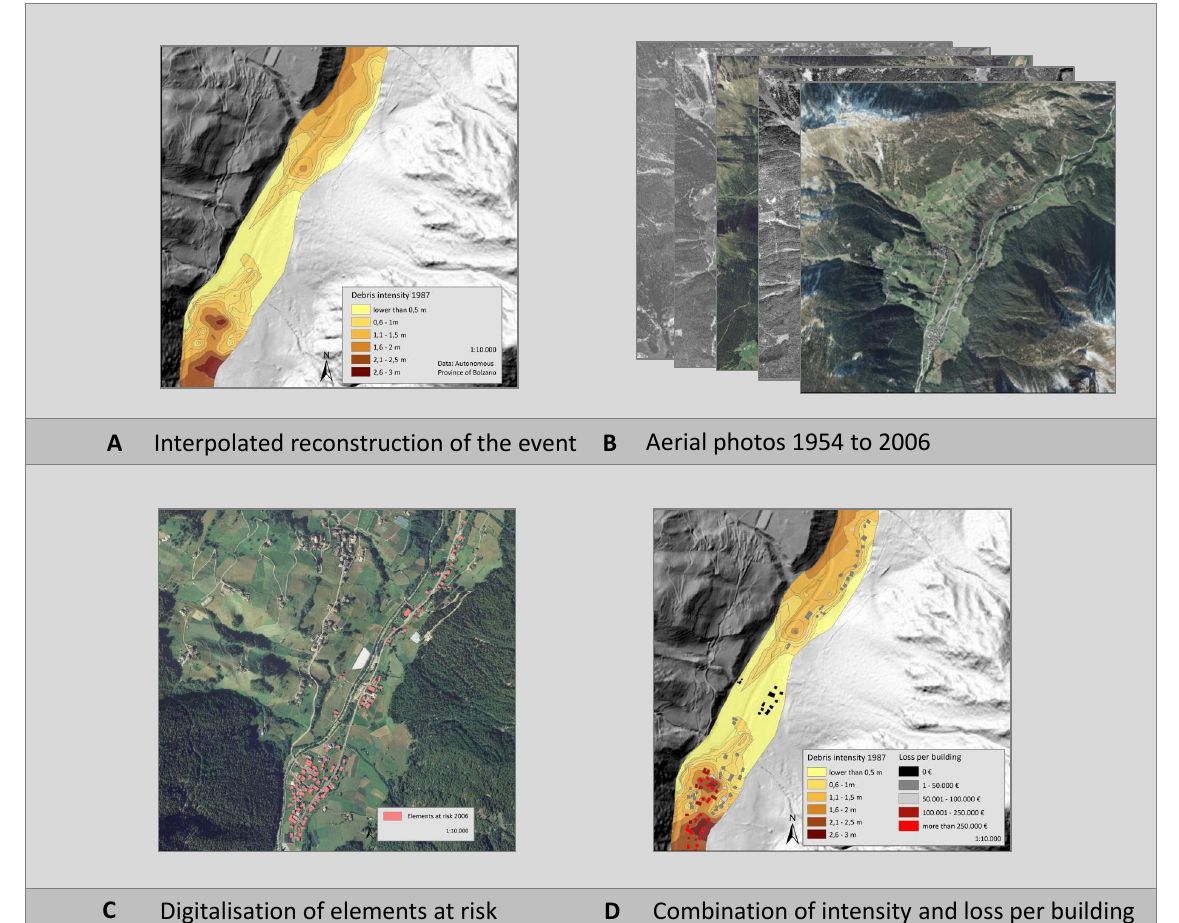
Fig. 3. Framework of the methodology: (A) The interpolated intensity map is based on the debris flow depths measured for individual buildings. (B) Aerial images serve as digitalisation base to (C) detect the elements at risk for different points in time. (D) By using the vulnerability curve and the information regarding the intensity the degree of loss for each year of research can be